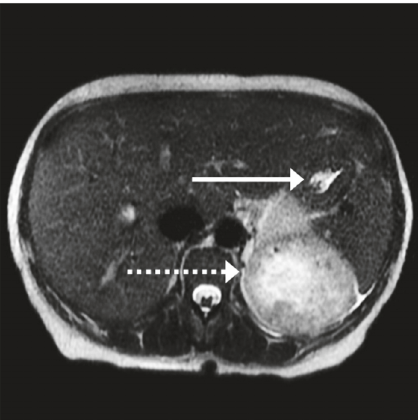
Figure 1: Axial & coronal view, CT of abdomen without contrast demonstrating multifocal left renal malignancy (dashed arrows) with metastasis to vagina as well as left hepatic lobe (solid arrows).